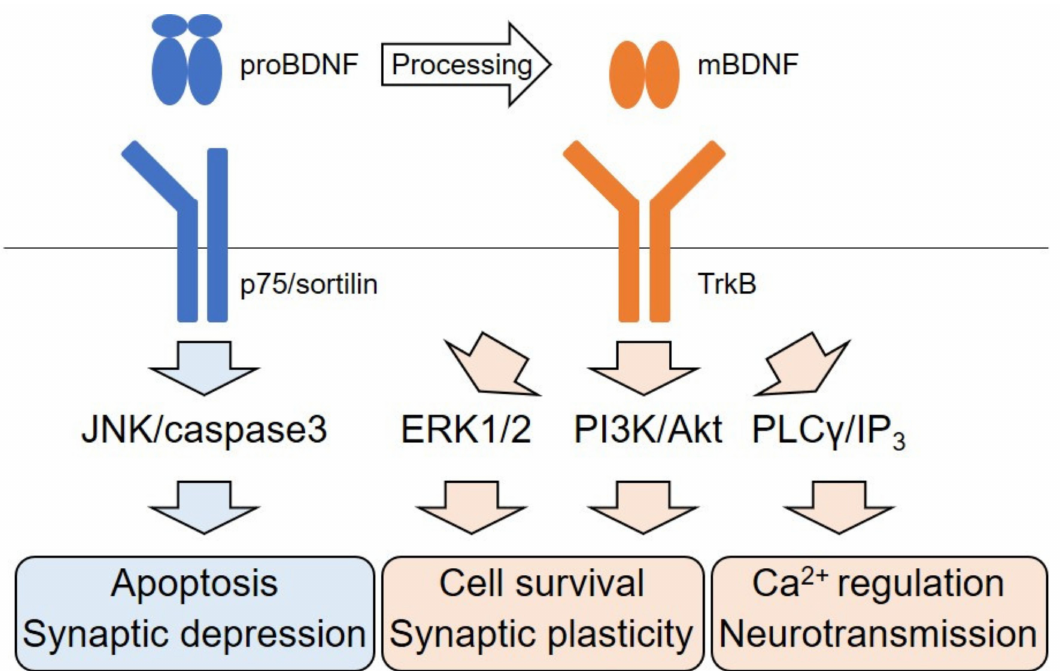
Figure 1. Schematic illustration of the BDNF signaling. The BDNF is initially translated as a precursor (proBDNF). proBDNF preferably binds with the p75-sortilin receptor complex and activates the JNK/caspase3 pathways which cause neural apoptosis and synaptic depression. proBDNF is proteolytically processed to a mature form (mBDNF). Binding of TrkB with mBDNF leads to activation of ERK1/2 and PI3K/Akt pathways to maintain cell survival and synaptic plasticity. mBDNF/TrkB also regulates Ca 2+ homeostasis and neurotransmission via the PLC γ /IP 3